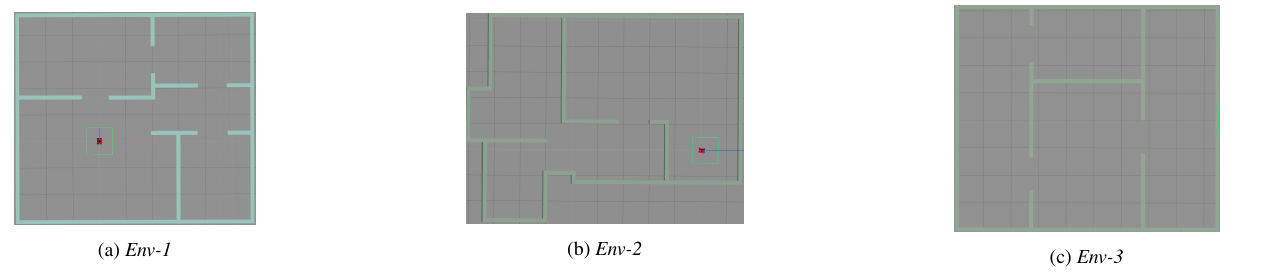
Figure 3. The training environment, Env-1 , and testing environments, Env-2 and Env-3 used for training and evaluating the proposed approach.